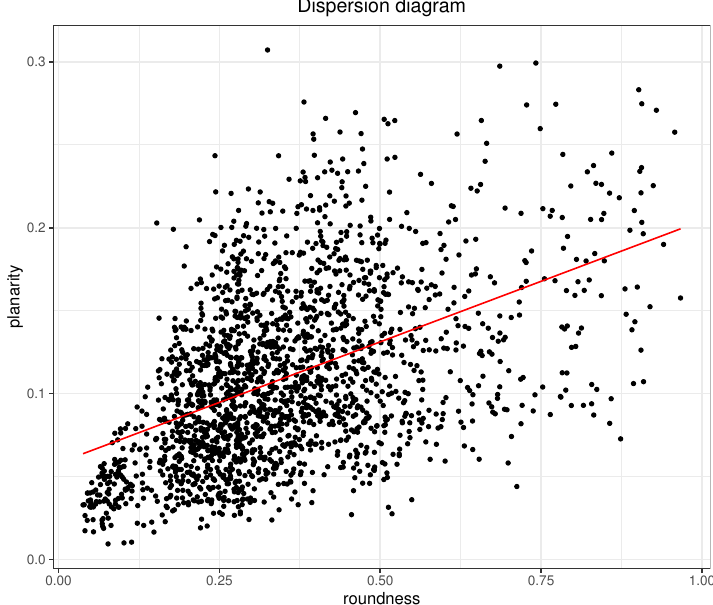
Figure 3. Dispersion diagram for ρ and ϕ for dataset including all analyzed P waves of the study. Pearson correlation is